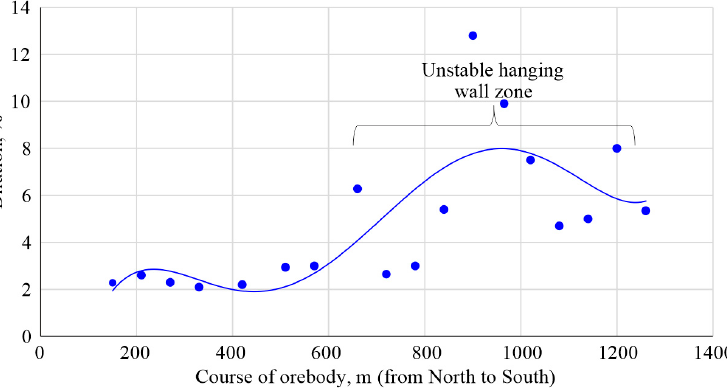
Figure 5. Distribution of the dilution value of ore mined from the stopes along the ore deposit strike.